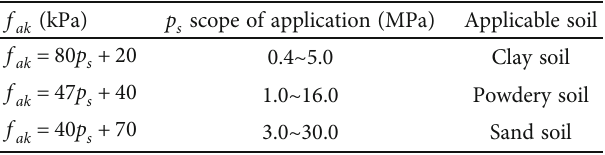
Figure 4: Work diagram of fi eld static penetration test. Table 1: Relationship between characteristic value f foundation bearing capacity and standard value of speci fi c penetration resistance.